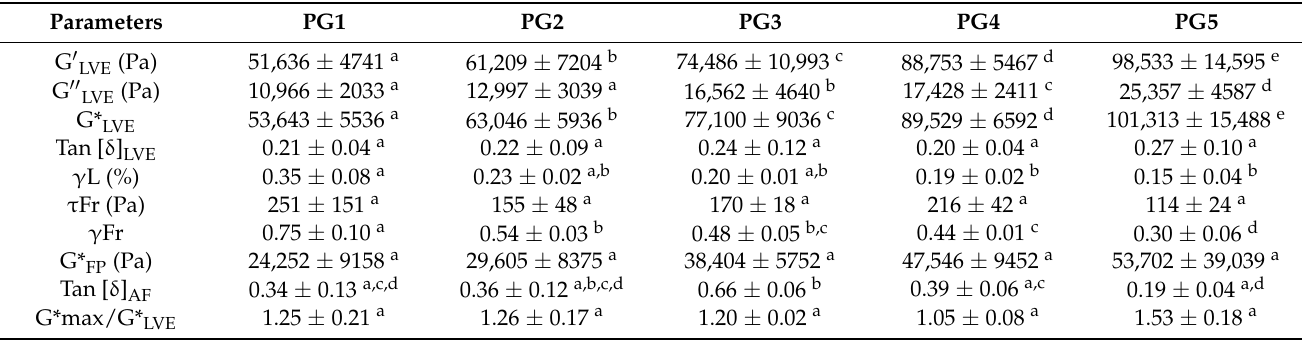
Table 1. Strain sweep for pectin hydrogels PG1–PG5 in the amplitude sweep test (1 Hz. 20 ◦ C).